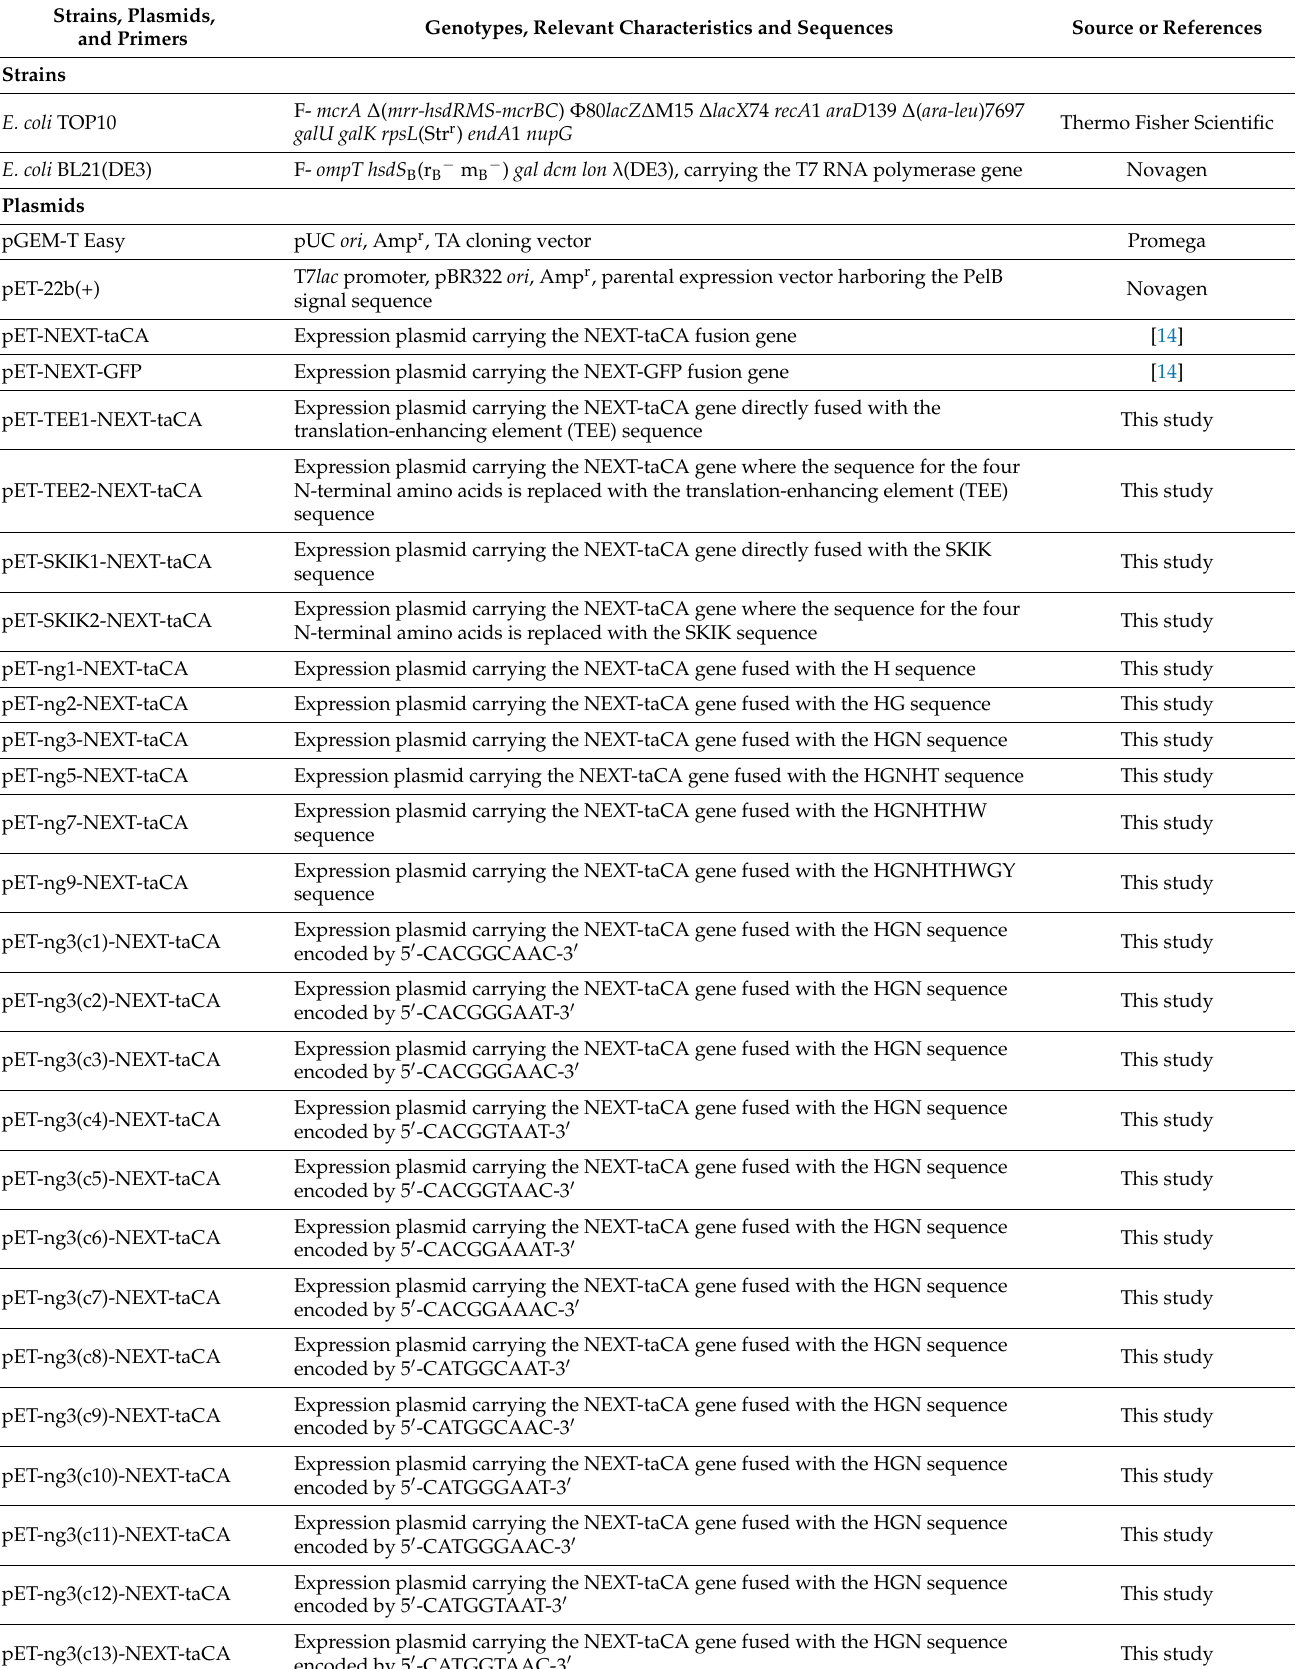
Table 1. Strains, plasmids, and oligonucleotide primers used in this study. Strains, Plasmids, Genotypes, Relevant Characteristics and and Primers